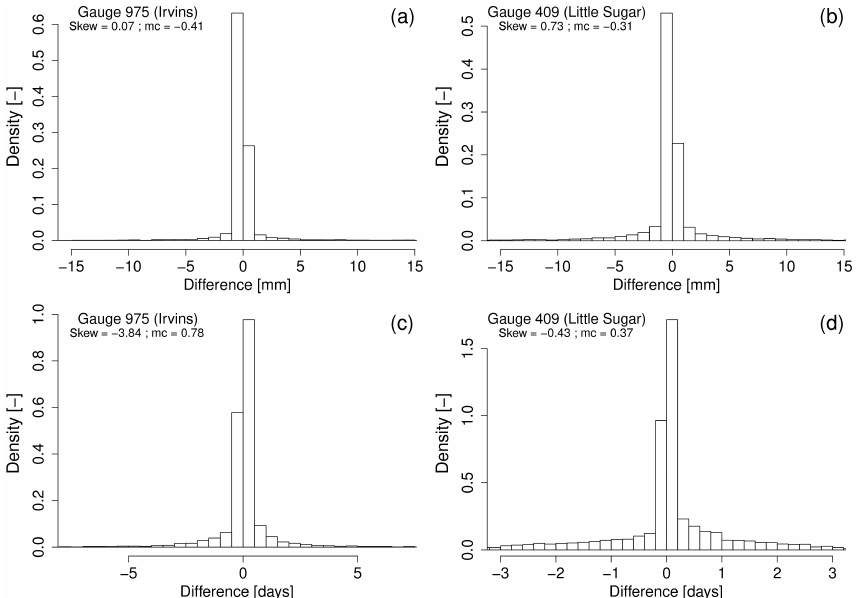
Figure 6. histograms of first-order differences in flows (a, b) and inter-amount times (c, d) , at 24h analysis sampling scale, for Irvins Creek and LSugarM